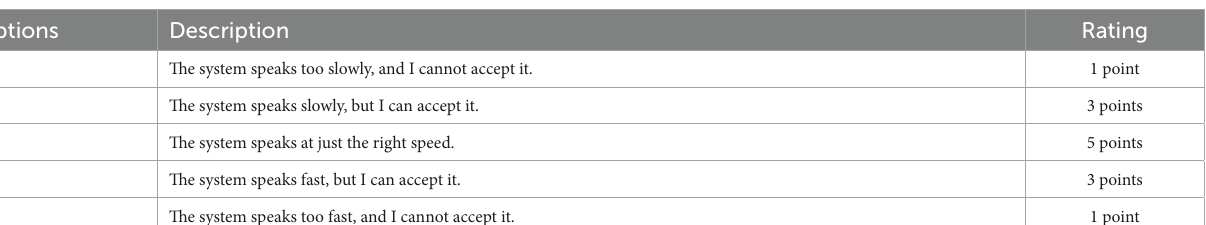
TABLE 4 Speech rate satisfaction